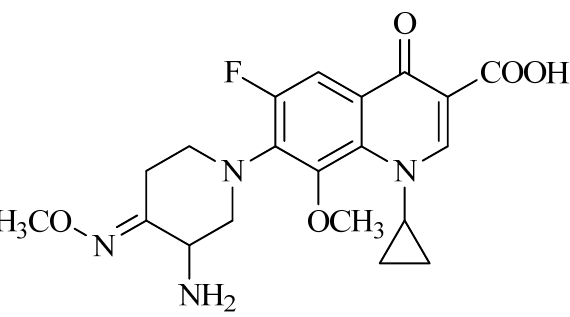
Figure 1. Structure of